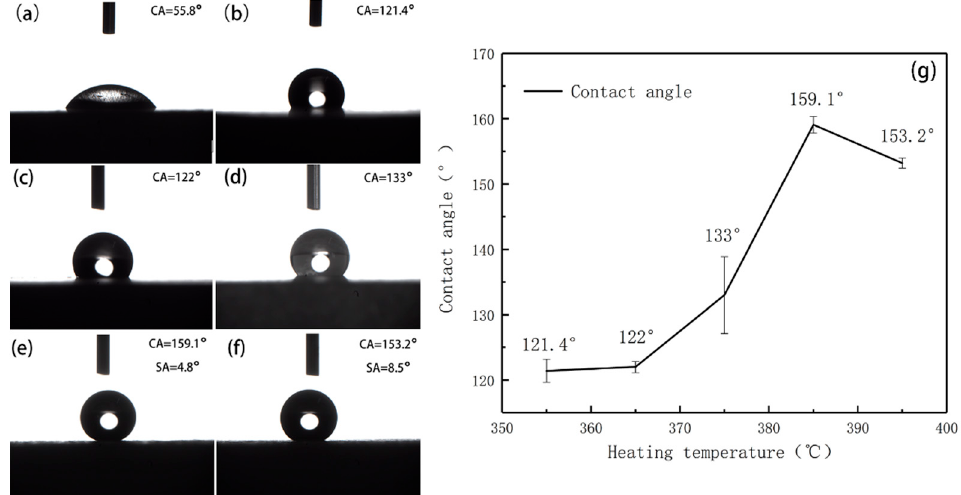
Figure 1. Contact angle images of the magnesium substrate ( a ) and samples with different heating temperatures: ( b ) 355 °C, ( c ) 365 °C, ( d ) 375 °C, ( e ) 385 °C, ( f ) 395 °C; Contact angle change trend ( g ). temperatures: ( b ) 355 ◦ C, ( c ) 365 ◦ C, ( d ) 375 ◦ C, ( e ) 385 ◦ C, ( f ) 395 ◦ C; Contact angle change trend ( g